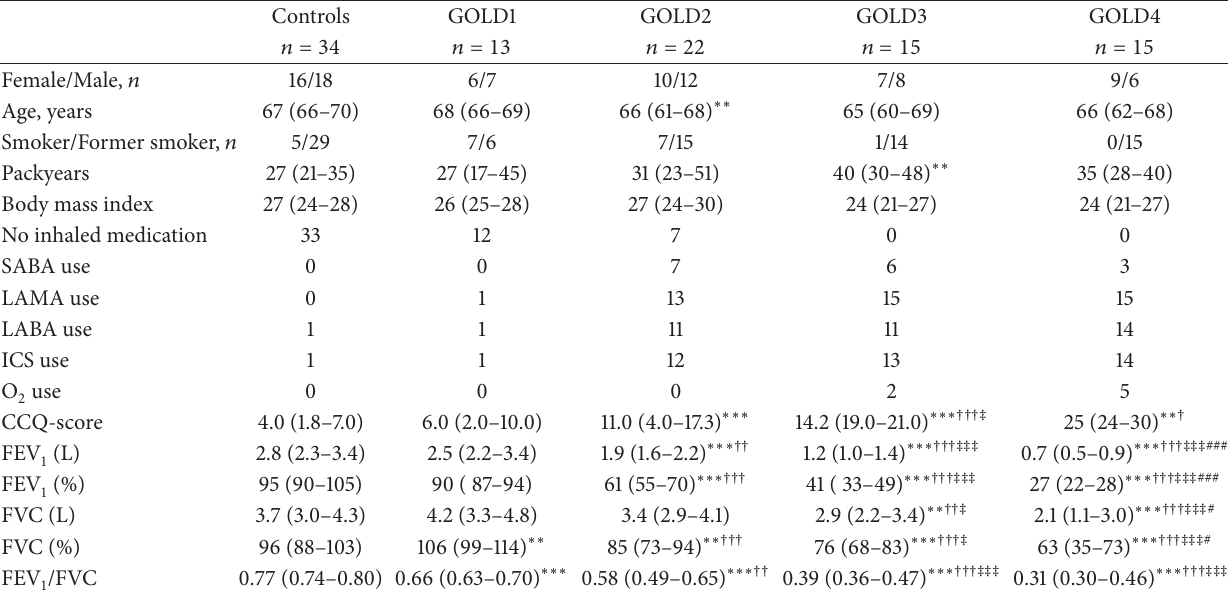
Table 1: Patient